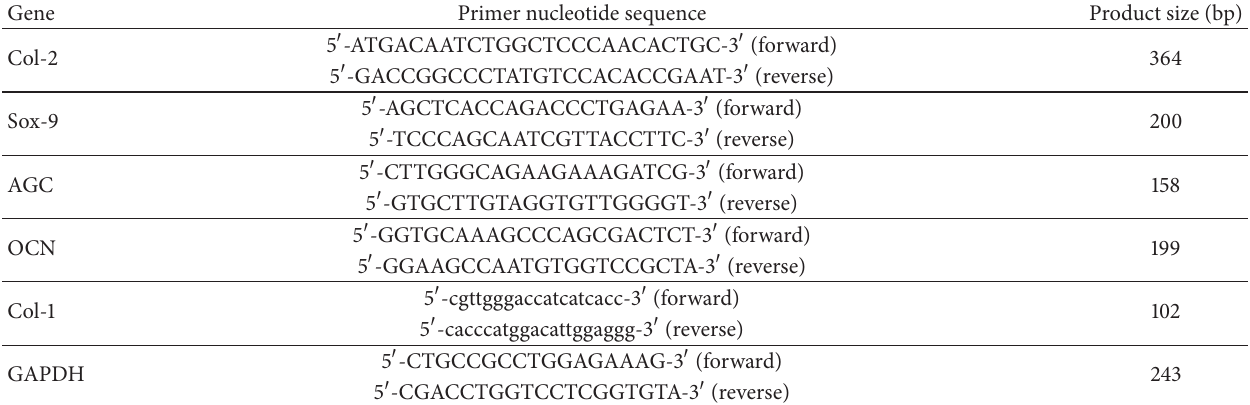
Table 1: Primer sequences and conditions for qualitative real-time polymerase chain